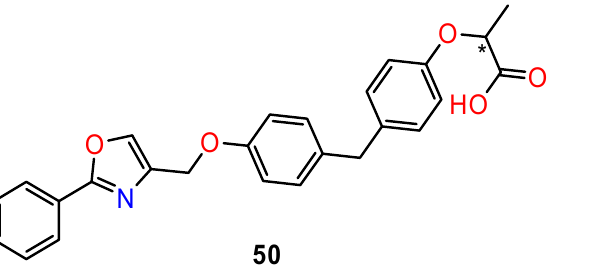
Figure 21. The basic structure of chiral diphenylmethane derivatives as PPAR α / γ agonists. * stereogenic centre.